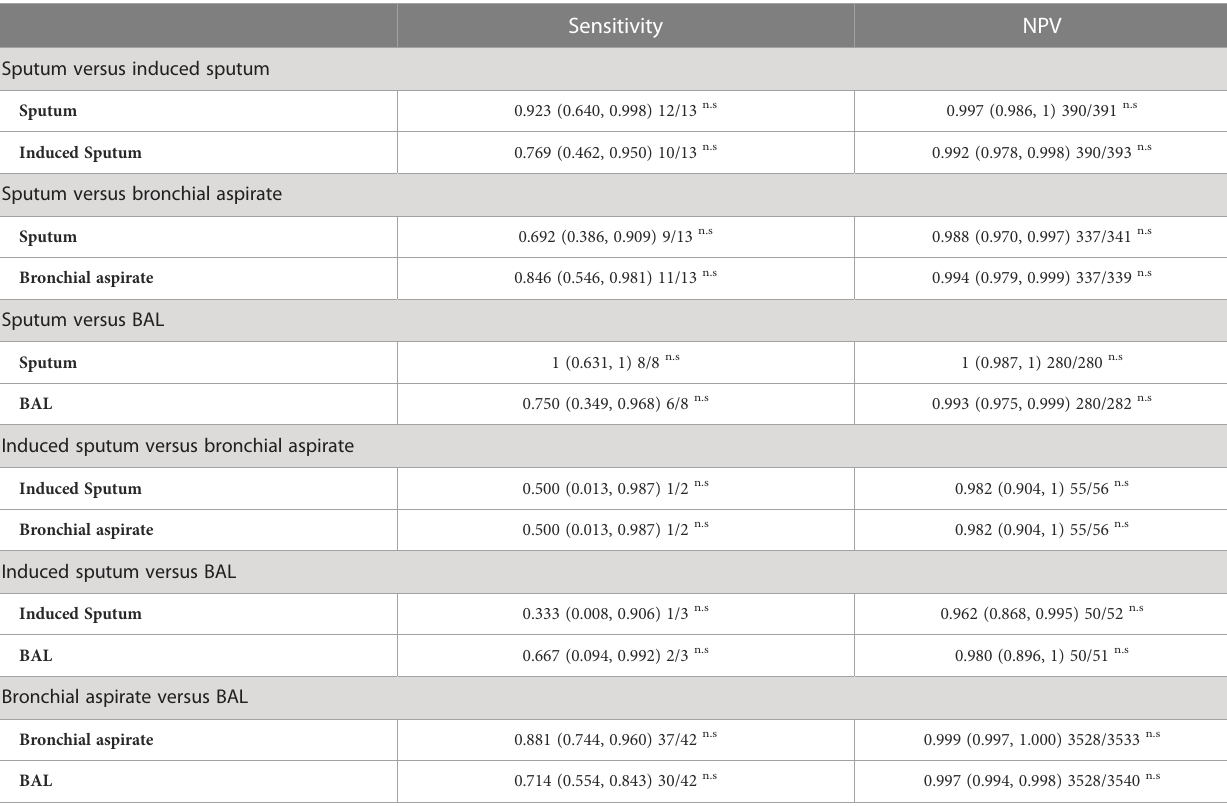
TABLE 4 Sensitivity of microscopy to predict tuberculosis according to the type of specimen using a 72-hours pairing window in the same patient. Sensitivity NPV Sputum versus induced sputum